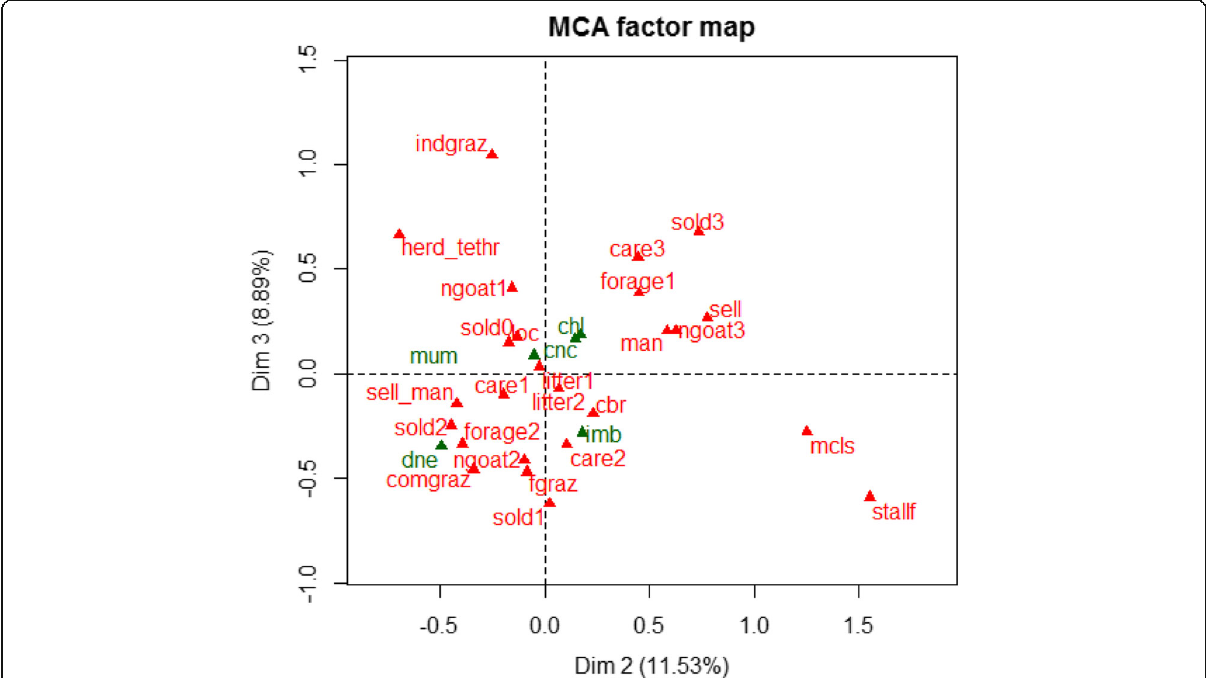
Fig. 3 Result of the multiple correspondence analysis of the answers to a survey of goat keepers in Burundi: graphical representation of modalities for the second (Dim 2) and third (Dim 3) dimensions. See signification of codes in Fig 2